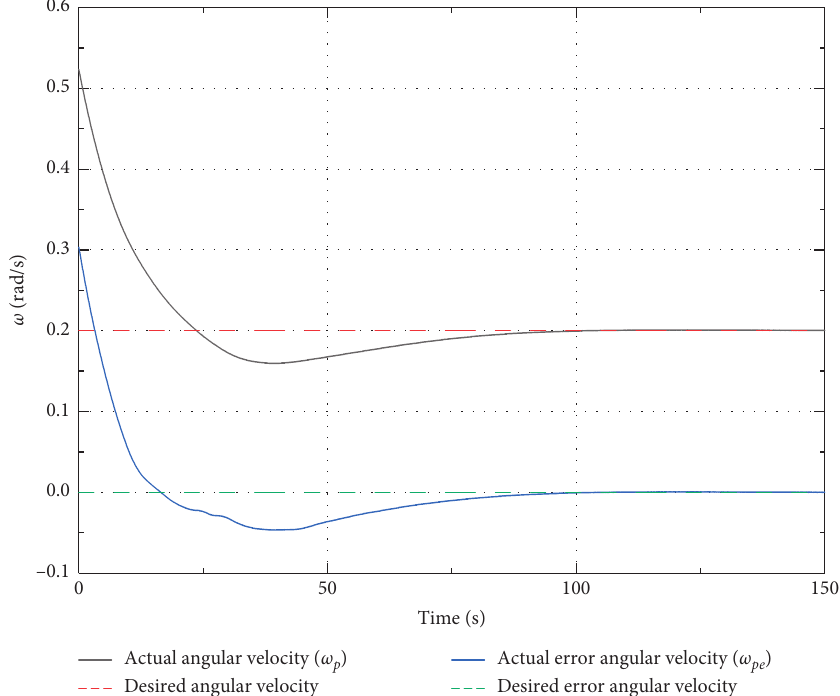
Figure 7: Trajectories of angular velocity and error of angular velocity of the large rigid inertial